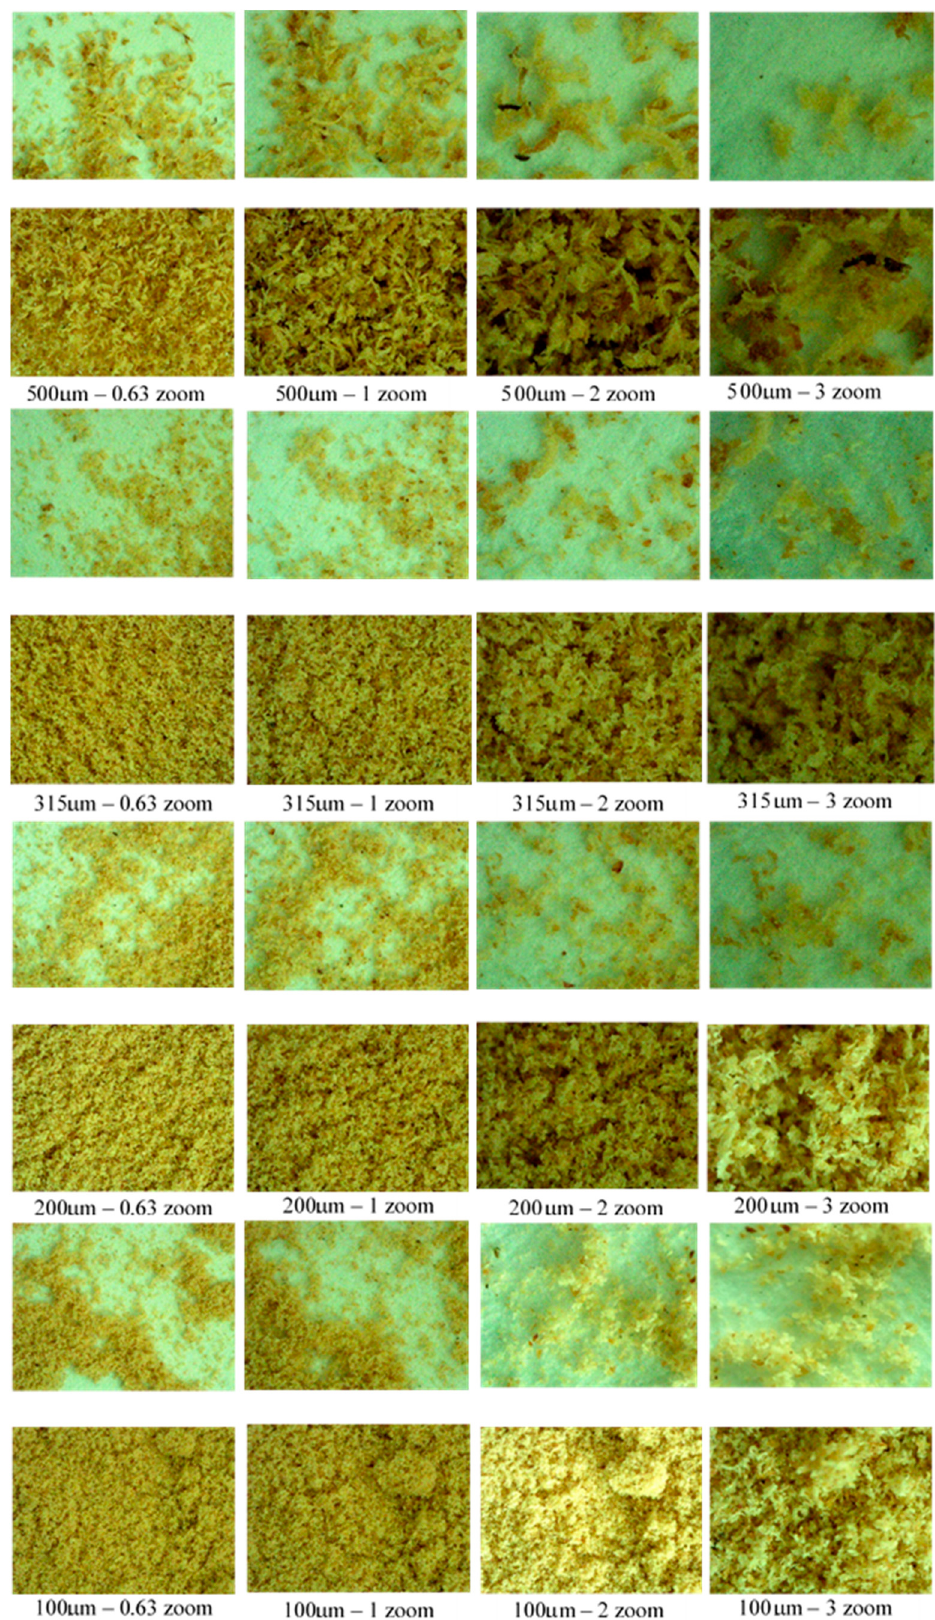
Figure 4. MW dust particles and their shape measured by Nikon Eclipse Ni with Nikon DS-Fi2 camera.